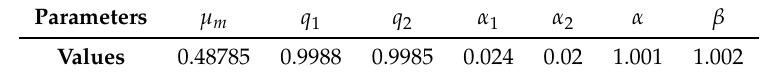
Table 1. Physical parameters in Equation (7).